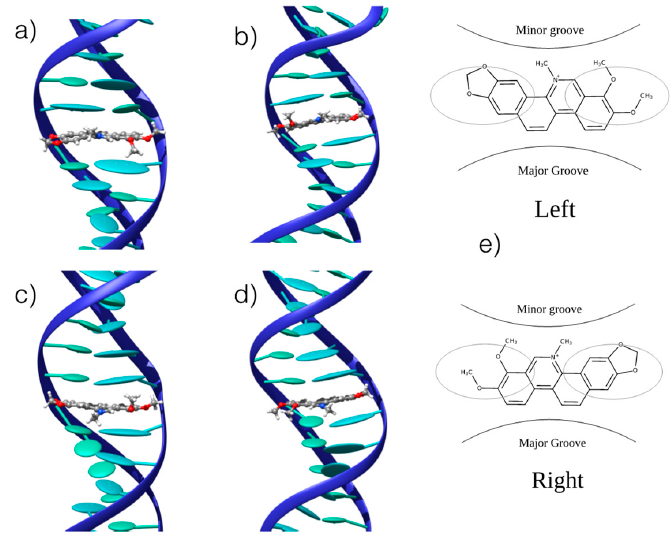
Figure 3. Representative snapshots of the stable interaction modes between CHE and B-DNA: ( a ) he-AT left orientation; ( b ) he-AT right orientation; ( c ) ho-AT left orientation; ( d ) ho-AT right orientation. ( e ) Schematic representation of the of the two competitive left and right interaction modes. The ellipsoids represent the π -stacked nucleobases. CG strands give similar structures that are reported in the Supplementary Information.